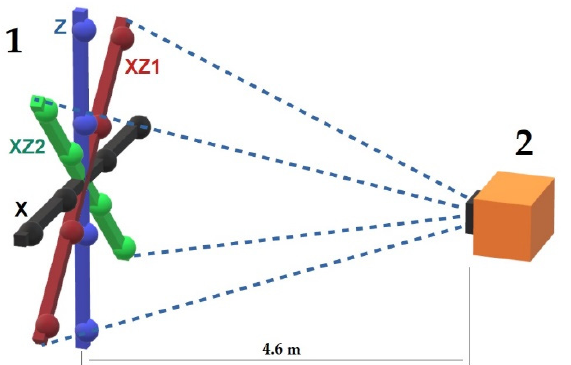
Figure 4. Ball-bar positions in the projector workspace: 1—positions of the standard; 2—position of the